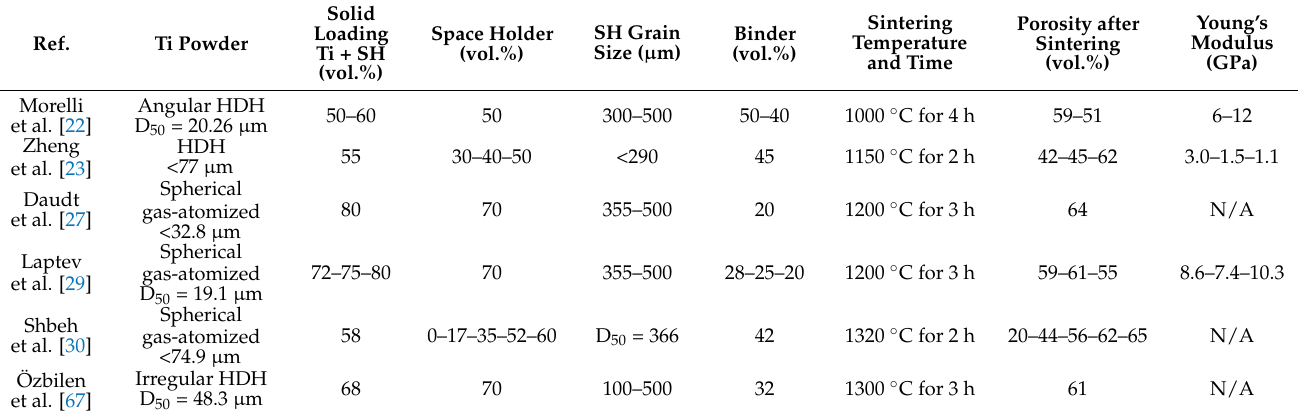
Table 3. Summary of feedstock configurations found in the